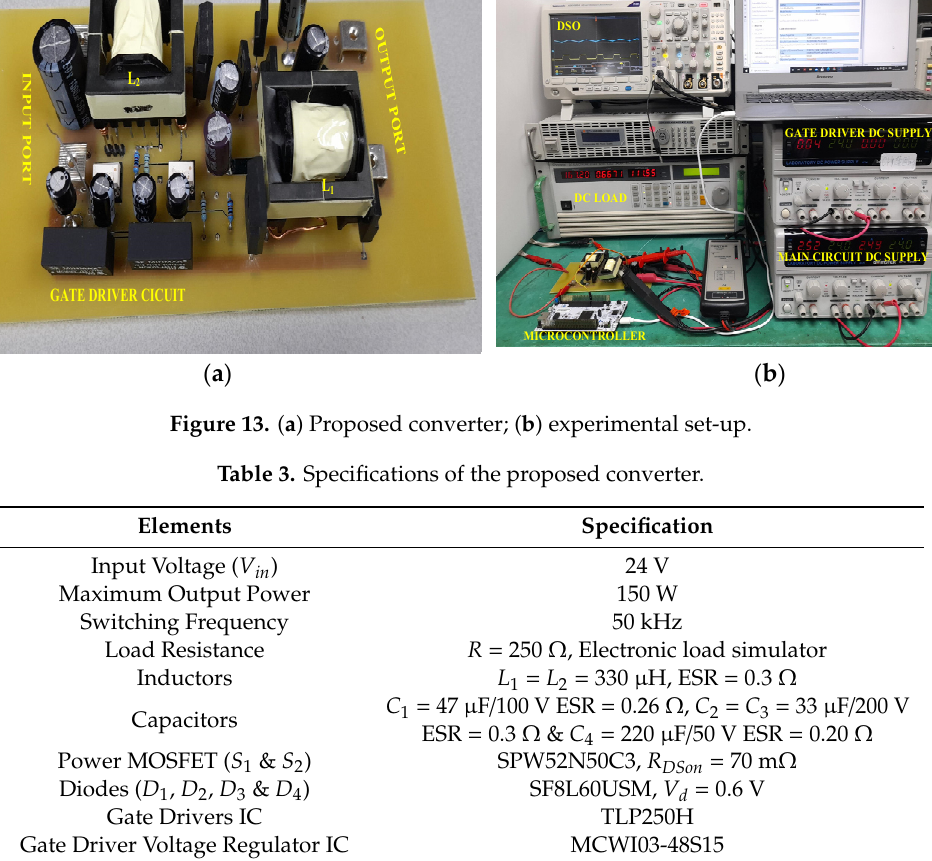
Figure 14. Output voltage at 24 V input and D = 0.4.